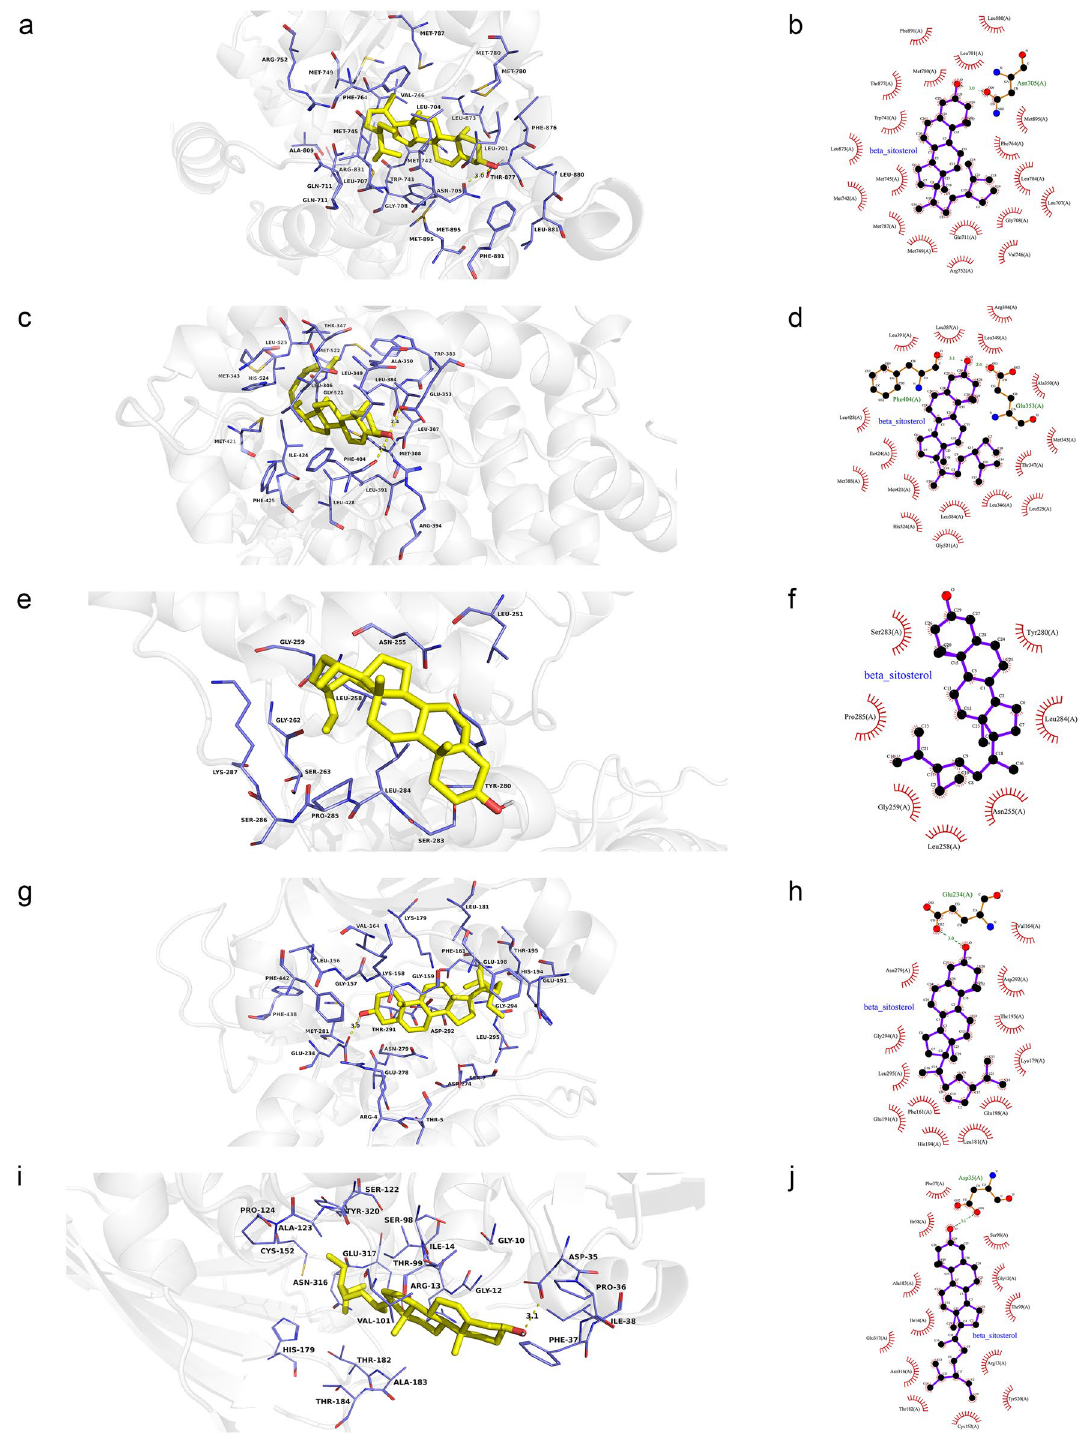
Figure 13. Molecular models of the binding of beta-sitosterol from MO and LB to the predicted targets ( a , b ) AR, ( c , d ) ESR1, ( e , f ) MAPK3, ( g , h ) AKT1 and ( i , j ) GAPDH shown as 3D diagrams and 2D